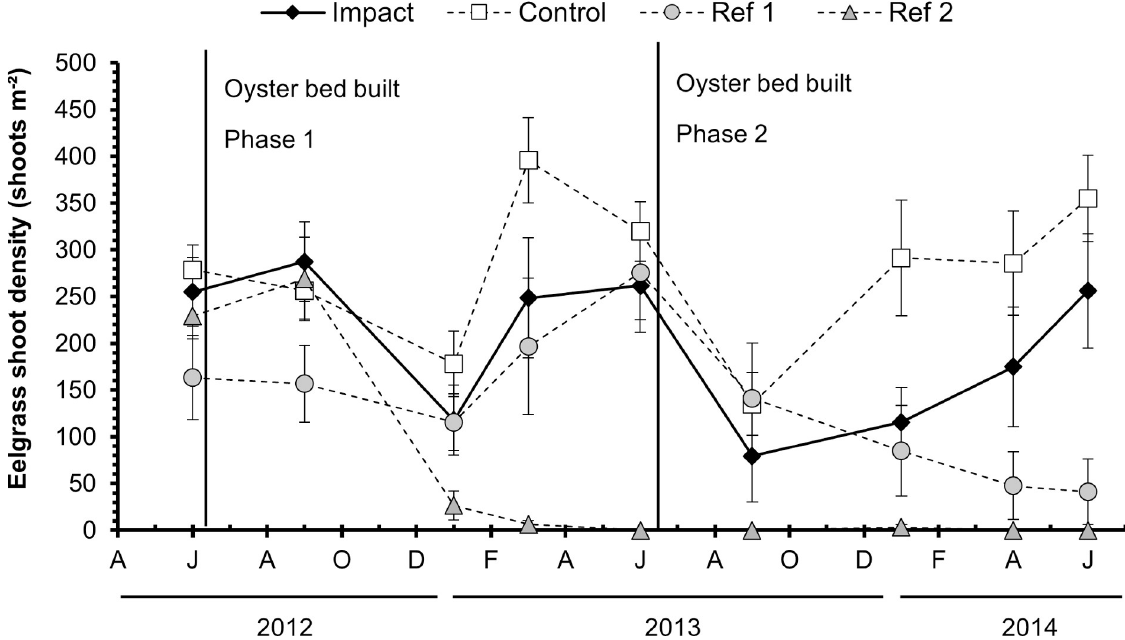
Fig 4. Eelgrass shoot density over time. Mean eelgrass shoot density at each location each month (n = 20 quadrats month -1 location -1 ). Vertical lines show timing of oyster bed constructions. Error bars show 95% confidence intervals. The results of pairwise comparisons between shoot density means are reported in S1 and S2